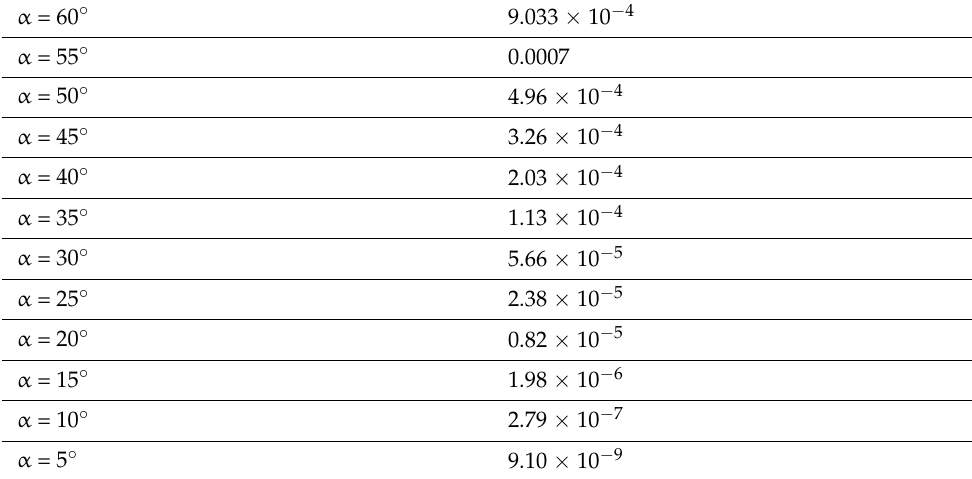
In Figure 7, the maximum aberrations, expressed in degrees, as a function of the max- imum scanning angle, in degrees, for three different values of the F/D, are plotted. The diameter of the front lens is again fixed to 30 λ . The continuous curve refers to the case F/D = 1; the dashed curve is valid for F/D = 1.25 while the dotted curve for F/D = 1.5. As expected, the aberrations increase with the scanning angle and by reducing the F/D value.